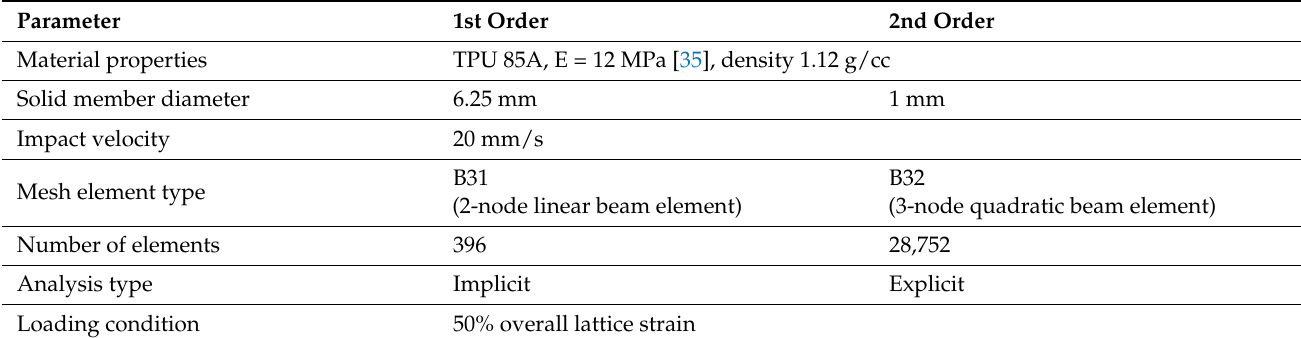
Table 1. Simulation parameters for all first- and second-order